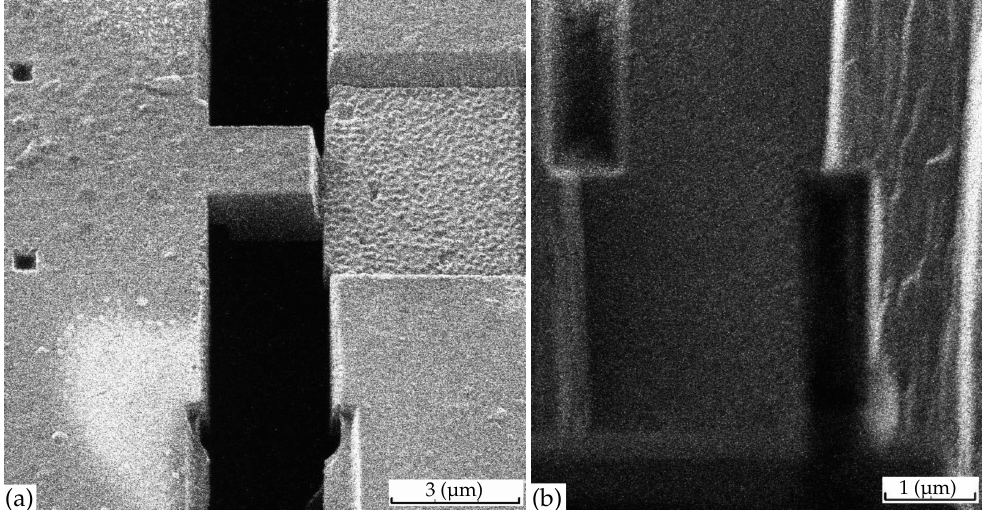
Figure 1. Photos of the microbridges, used in our experiment, from two different angles. ( a ) illustrates the 3D shape of our mesa structure, while ( b ) shows its